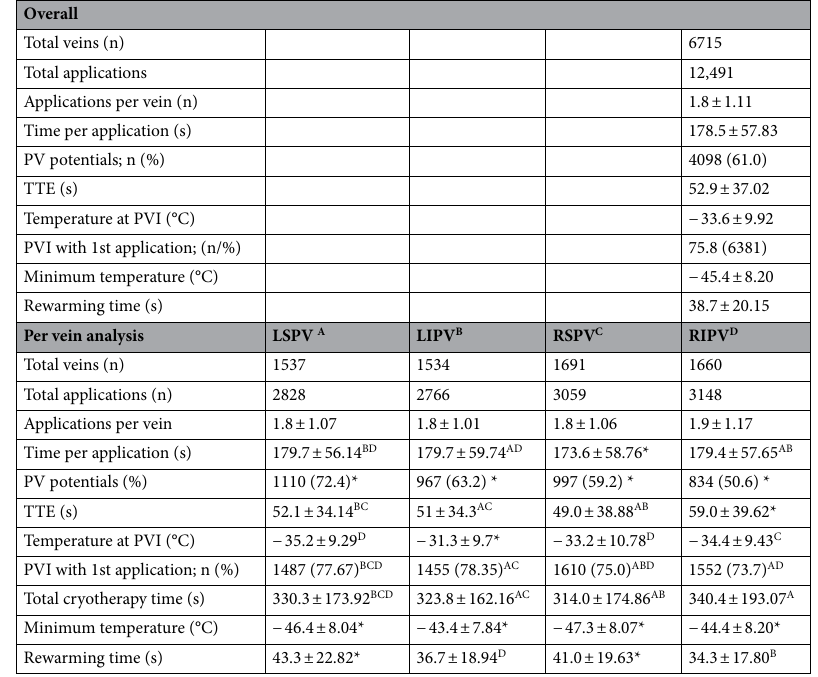
Table 4. Acute procedural results. Global and per vein application analysis. Differences on averages by patient-location, since multiple applications could have received at each patient-location (on average 1.8 applications over each location) are shown, using a mixed-effects model and adjusting for multiple comparisons (Bonferroni). Locations with a significantly different value (p < 0.001) differing from all other locations are flagged with an asterisk. When the average compared is not different from another location (p > 0.05), the value is labeled with a letter corresponding to the non-significant locations (labeled from left to right: A, B, C, D). Quantitative data are the mean ± standard deviation. PV pulmonary vein, PVI PV isolation, TTE time to effect, LSPV left superior pulmonary vein, LIPV left inferior pulmonary vein, RSPV right superior pulmonary vein, RIPV right inferior pulmonary vein.